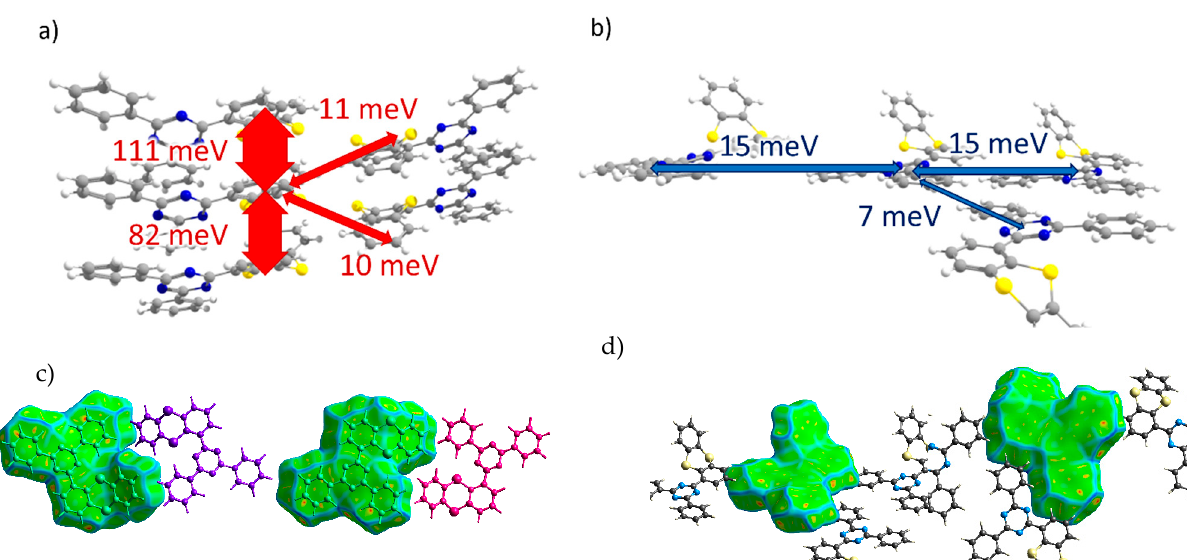
Figure 3. Charge transfer integrals for hole ( a ) and electron ( b ) transport in oTE-DRZ crystal. ( c , d ) Intermolecular contacts that enable these transfer integrals; the left and right pictures correspond to the different sides of the central molecule. The Hirshfeld surface for the central molecule was mapped with curvedness. The coloring scale is depicted in Figure 2.